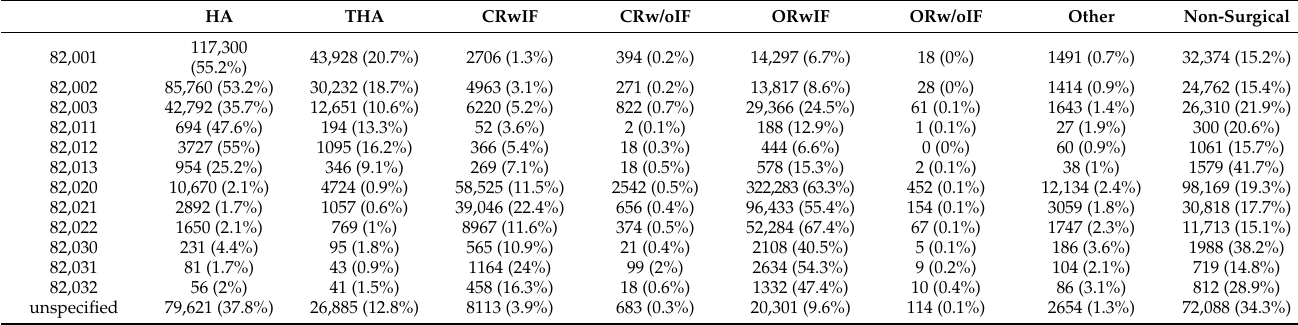
Table 3. Type of fracture and therapeutic strategy.